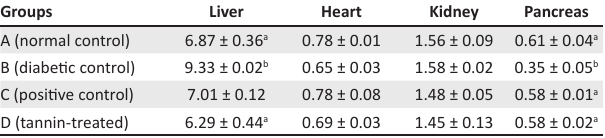
TABLE 2: Effects of tannins on organ weight (grams) of control and diabetic rats. Groups Liver Heart Kidney